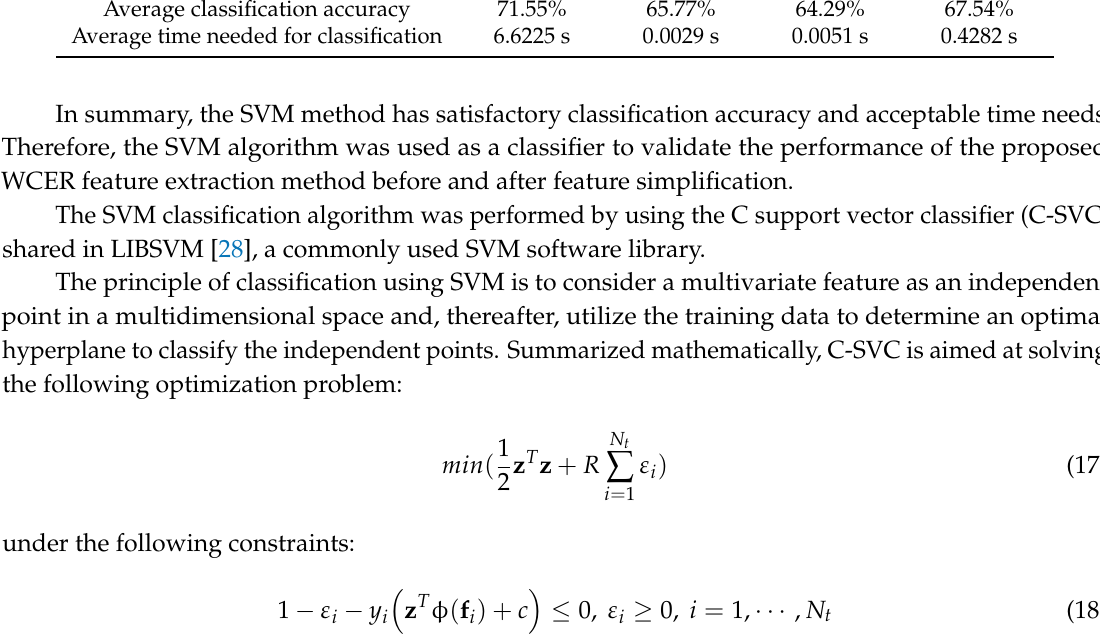
Table 3. Average classification accuracy and time needed for different classification methods using acoustic features without simplification. KNN, k-nearest neighbor; DT, decision tree; NB, naïve Bayes; SVM, support vector machine. KNN DT NB